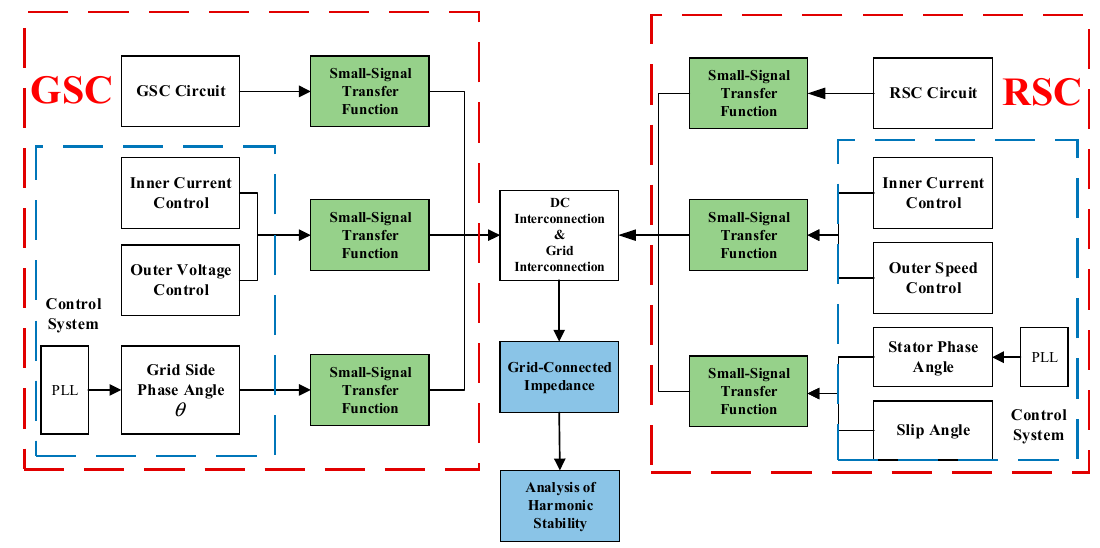
Figure 1. The logic path of modeling and analysis procedures in this paper. Both rotor side convertor (RSC) and grid side convertor (GSC) models can be divided into two parts: the main circuit module and the control module with PLL.